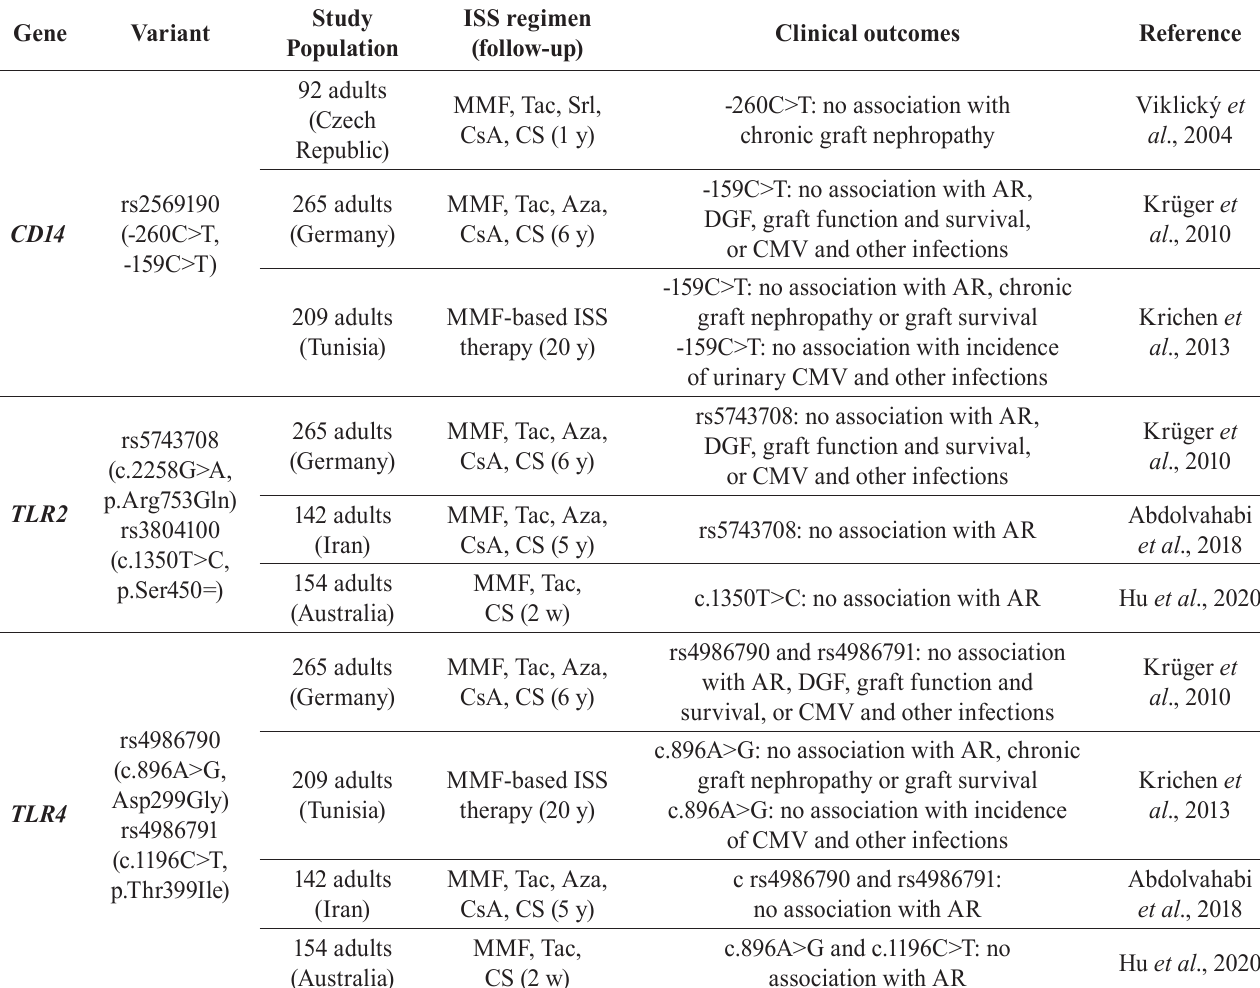
Table VI - Genes related to innate immune response in kidney recipients on MPA therapy without significant associations Gene